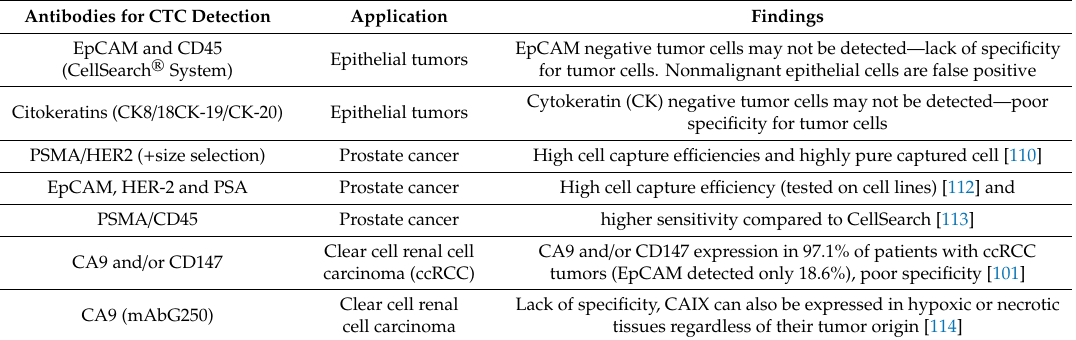
Table 4. Antibodies used for CTC detection in genitourinary